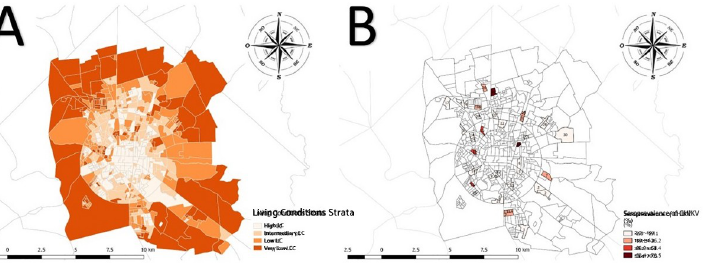
PLOS NeglectedTropical Diseases | https://doi.org/10.1371/journal.pntd.0009289 April 20,